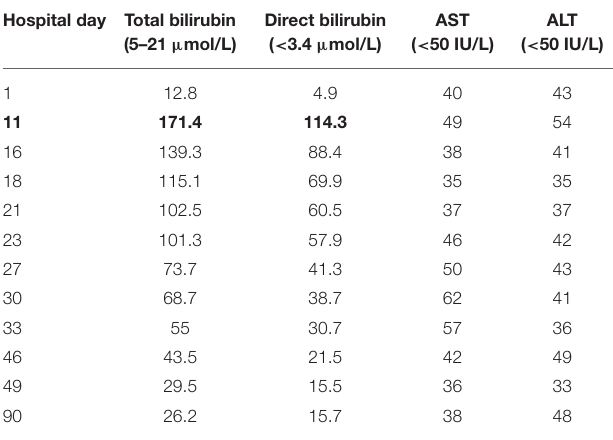
TABLE 1 | Specific hematologic and serum biochemical data in a patient with metastatic gastric cancer and rare severe immune-related cholestatic hepatitis and subsequent severe late-onset pneumonia after pembrolizumab therapy.